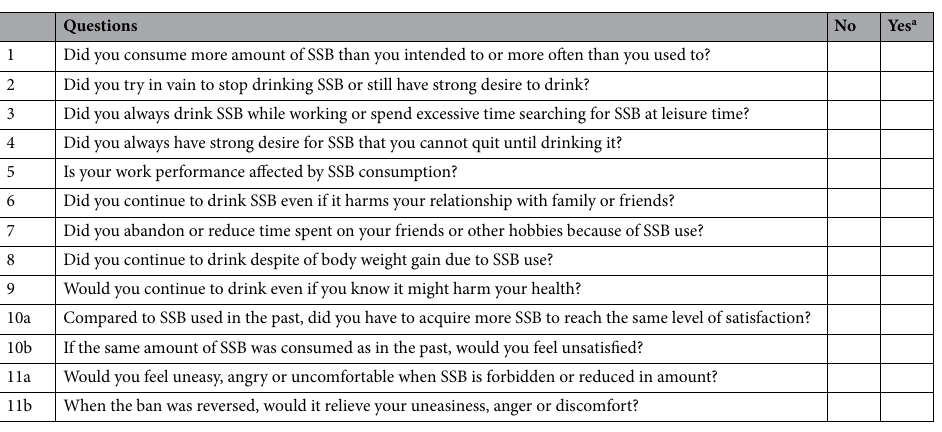
Table 1. Modified DSM-5 diagnostic criteria for SSB use tendency. a Each positive response scores 1